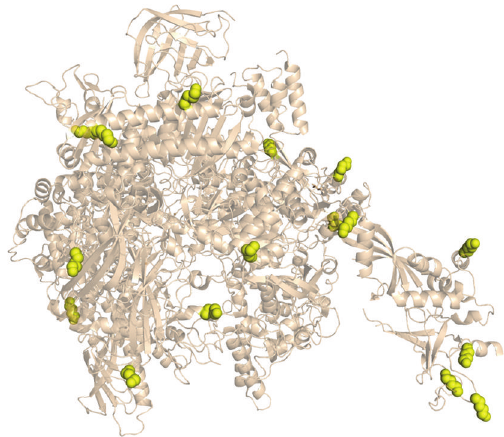
Figure 3: Mapping lysine methylation sites on the RNA polymerase crystal structure. The structure of RNAP from S. shibatae is shown [16] with methylated lysines listed in Table 1 indicated in yellow. This figure was generated using Pymol (The PyMOL Molecular Graphics System, Version 1.2r3pre, Schr¨odinger, LLC.)